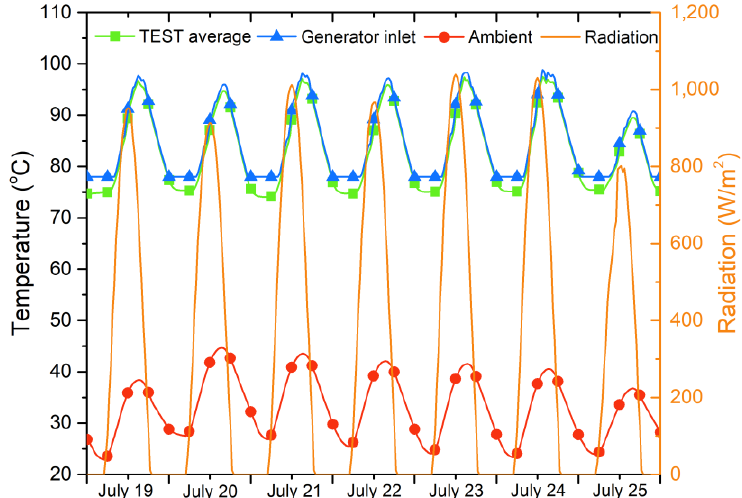
Figure 6. Variation of the average TEST temperature, system generator input temperature, and ambient temperature during an operational week.